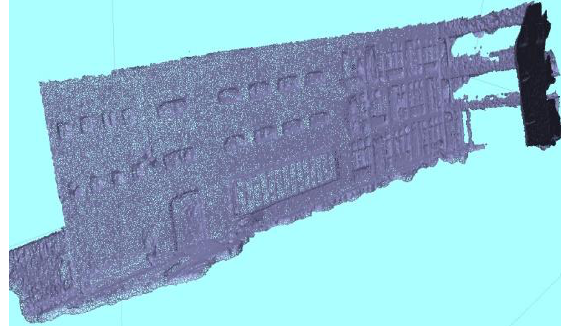
Figure 8: Wireframe model